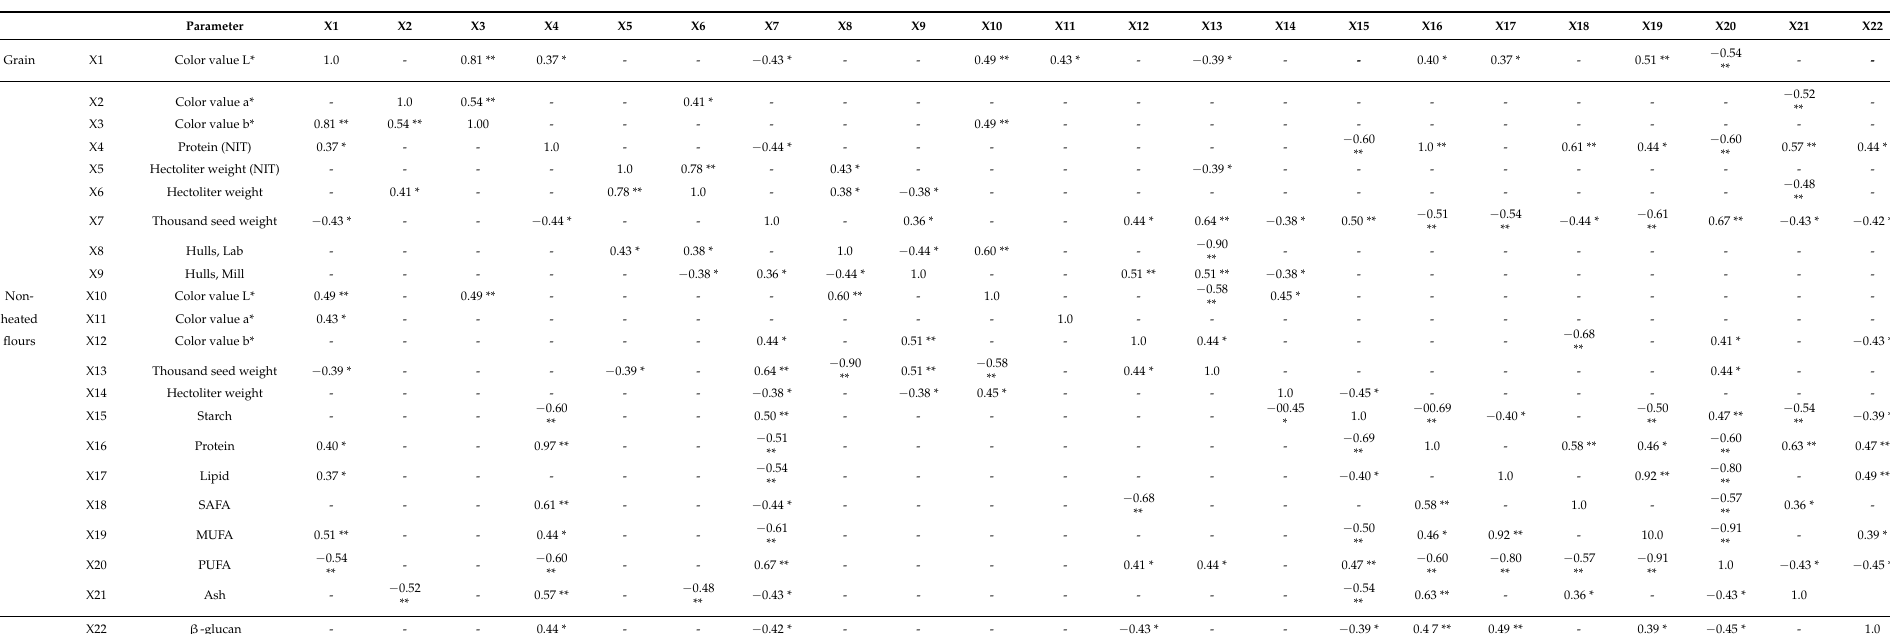
Table A5. Pearson correlation coefficients of 30 native oat grain and non-heated flour properties. The color values are L*, a* and b*. NIT, near-infrared transmittance; SAFA, saturated fatty acids; MUFA, monounsaturated fatty acids; PUFA, polyunsaturated fatty acids. Parameter